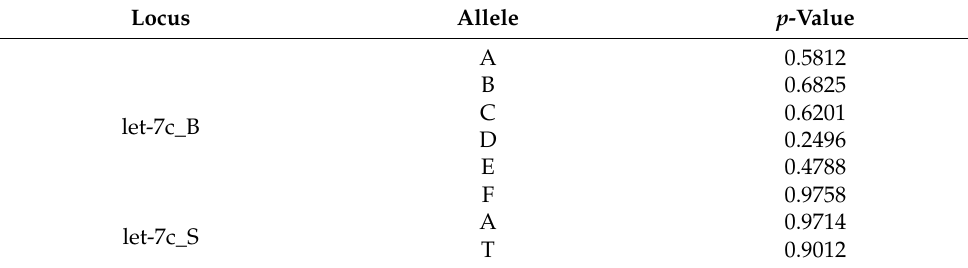
Table 4. Results of logistic analysis of identified SNP allele effects in Markhoz goats. Locus Allele p -Value